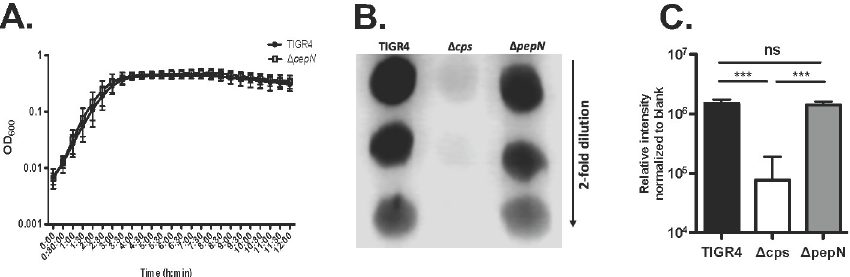
Fig 5. Mutants lacking PepN ( Δ pepN) demonstrate the same growth kinetics and capsule levels as wild-type TIGR4. A) TIGR4 and Δ pepN cells were grown to mid-log phase, back-diluted in fresh media to OD 600 0.003, incubated at 37˚C and OD 600 was measured every 30 minutes for 12h. Data presented are the means ± SD from 3 independent experiments. B and C) Capsule was isolated from OD 600 -matched, mid-log phase TIGR4, Δ cps and Δ pepN cells. For each strain, 5 μ L spots of a 2-fold serial dilution were applied to a nitrocellulose membrane, which was developed using an unconjugated rabbit anti-serotype 4 serum, HRP-conjugated goat anti-rabbit antibody and ECL Blotting Substrate. B) Data shown are from one blot representative of 3 independent experiments. C) Data presented are the means ± SD from 3 independent experiments. ��� , P < 0.001; ns = no significant difference. Statistical analyses were conducted using a one-way ANOVA and Tukey’s Multiple Comparisons Test.